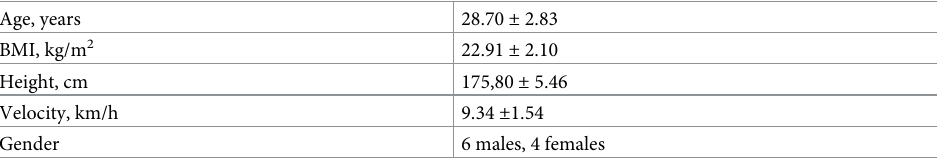
Table 1. Demographic and physiologic characteristics of the